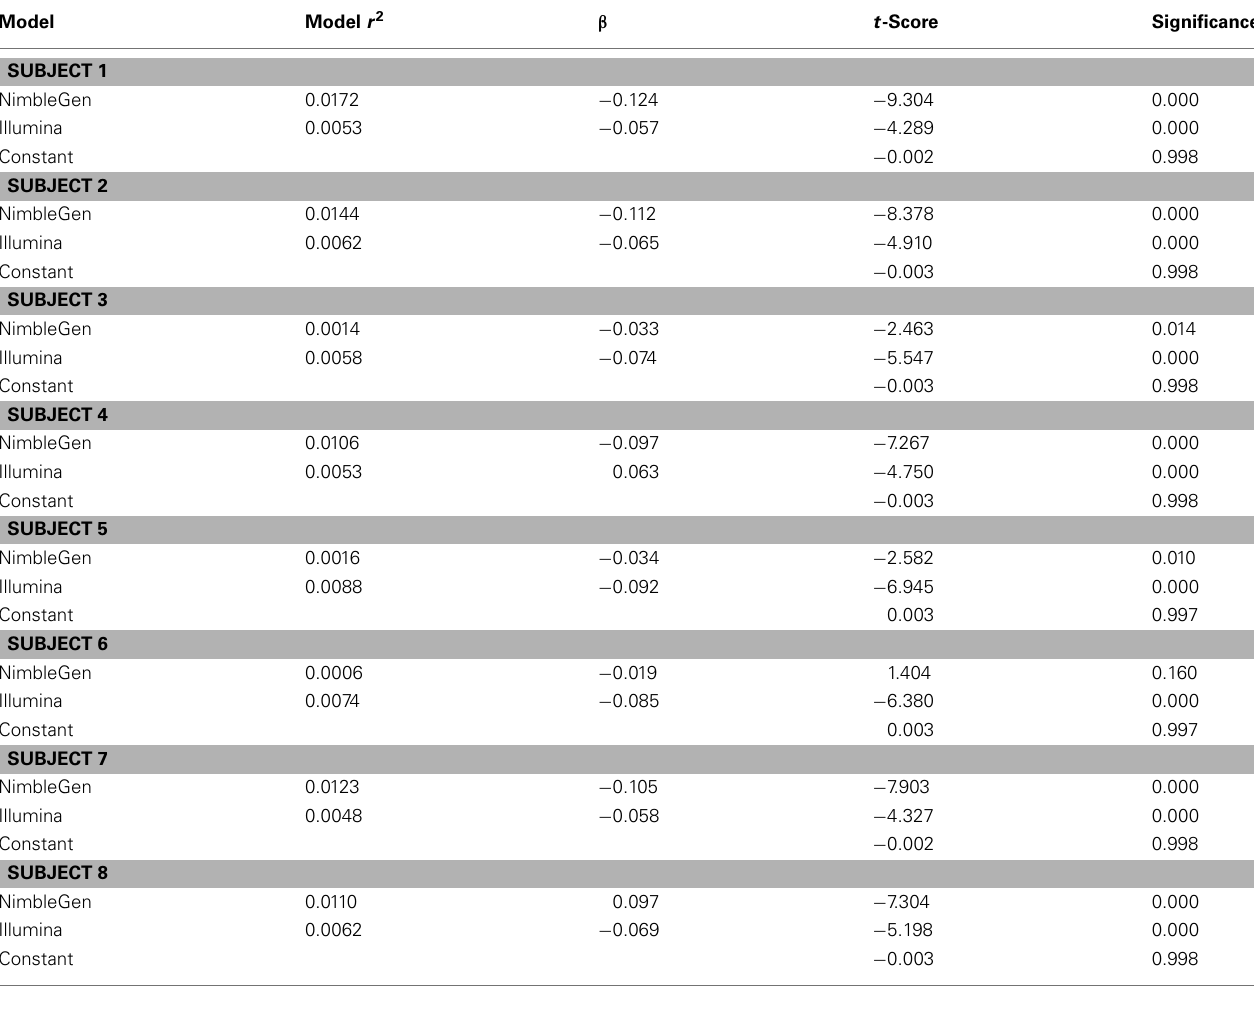
Table 3 | Ordinary least squares analysis of the relationship of methylation to gene expression.